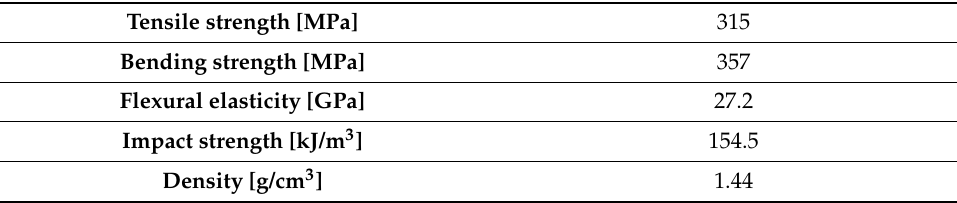
Figure 2. Hot forming of the WLF preform. Table 2. Mechanical properties of the cured WLF Preform.